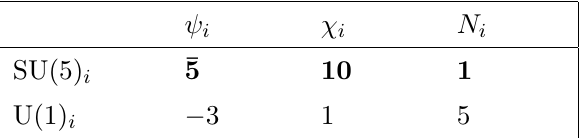
Table 1 . Fermionic (cid:12)eld (matter) content ( i = 1 ; 2 ; 3 ;